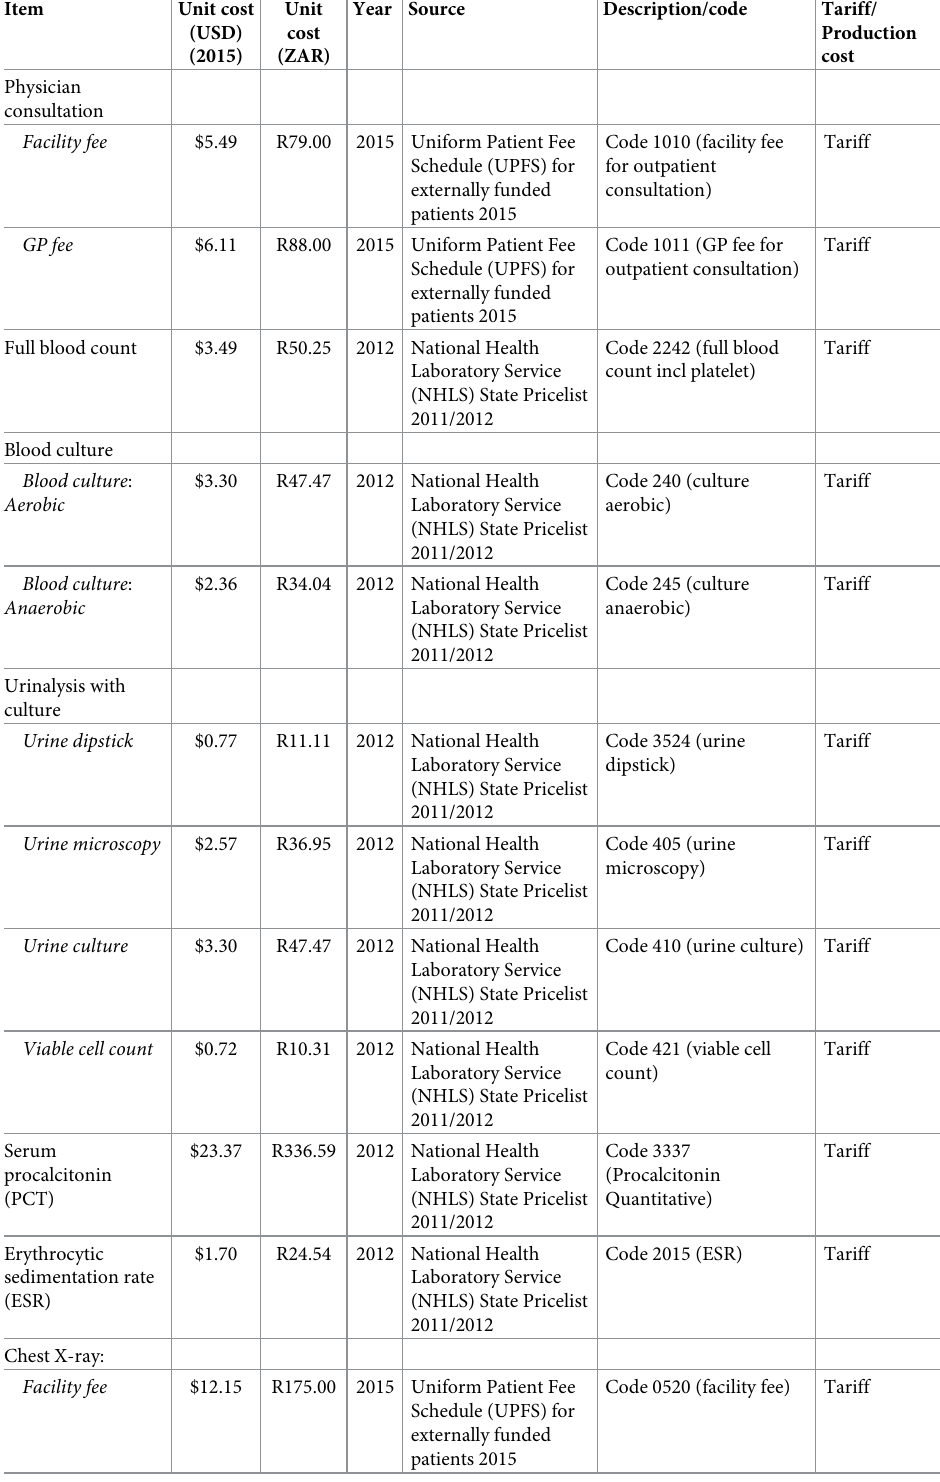
Table 7. Cost details for public health care sector